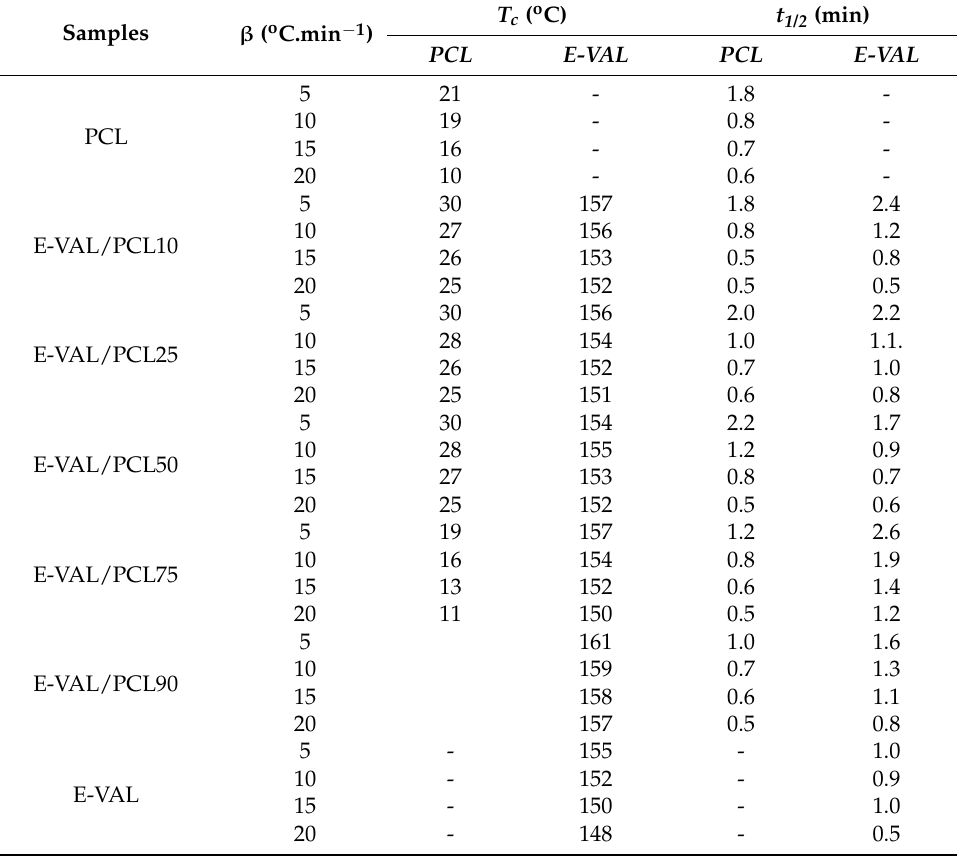
Table 8. Temperatures and t 1/2 of the crystallization of E-VAL and the E-VAL/PCL blends obtained by the non-isothermal crystallization